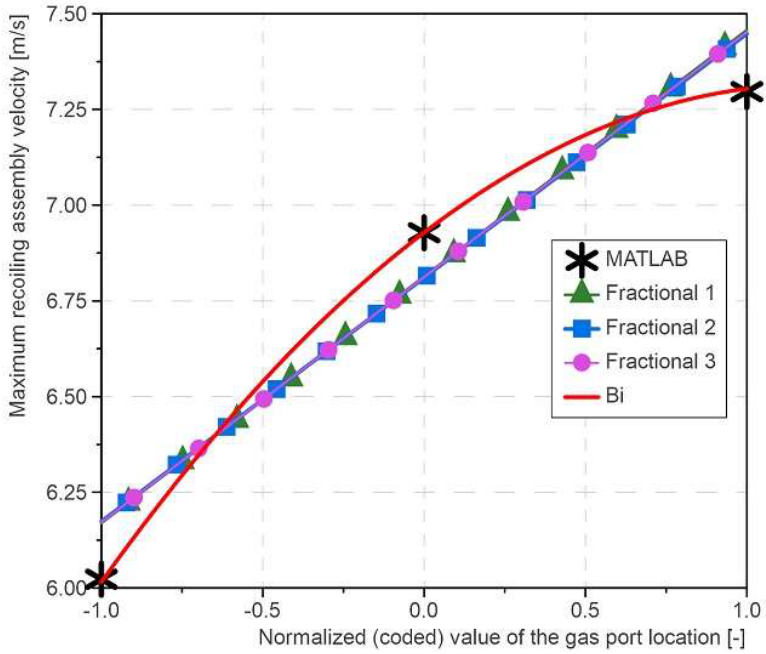
Figure 2. Diagram of the maximum recoiling assembly velocity as a function of the normalized (coded) value of the gas port location.